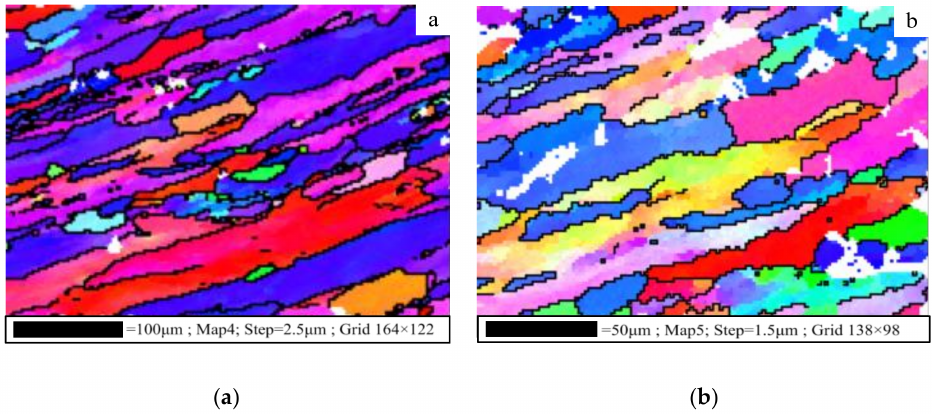
Figure 11. Microstructure of aluminum alloy 7050-T7451 in RD: ( a ) EBSD 500 × ; ( b ) EBSD 1000 ×